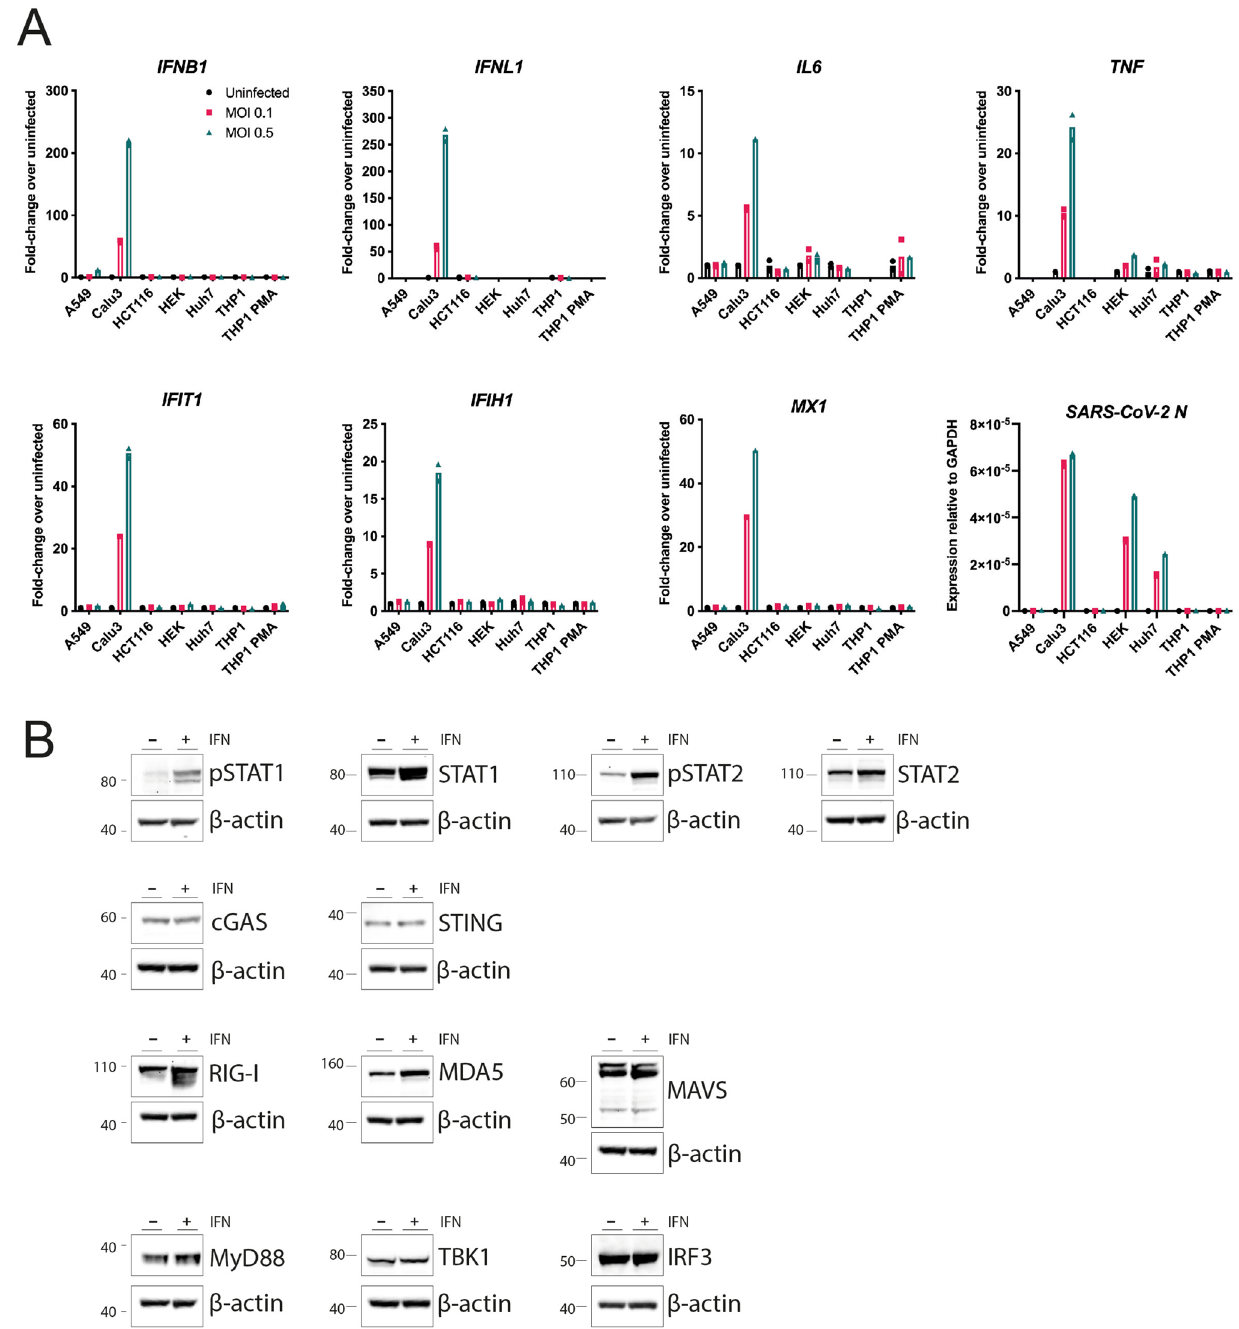
Figure 1. Calu-3 cells respond to SARS-CoV-2 infection by upregulating type I and III IFNs, ISGs and cytokines. ( A ) The indicated cell lines were mock-infected or infected with SARS-CoV-2 (MOI = 0.1 or 0.5) for 24 h prior to RNA extraction and RT-qPCR for the indicated transcripts. Data are relative to GAPDH expression. ( B ) Calu-3 cells were stimulated with 100 U/ml IFN-A/D for 16 h. Cell lysates were analysed by western blot using the indicated antibodies. Individual membranes were probed for each protein. Membranes were subsequently re-probed for β-actin. See Supplementary Figure 2 for full blots. Data are from a single experiment. Data points in ( A ) are from technical duplicates and bars indicate the